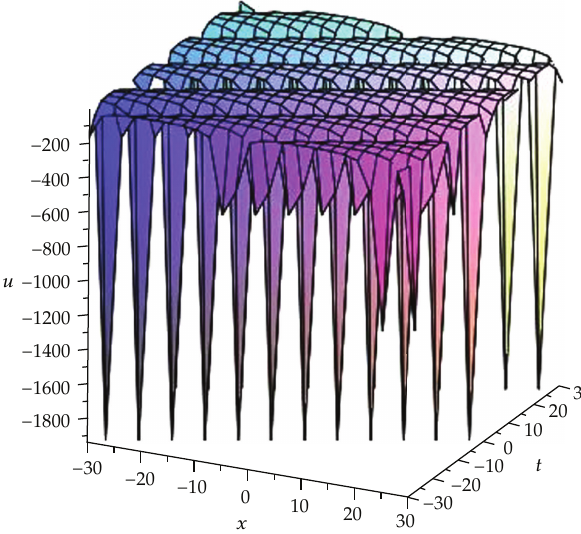
Figure 10: The solution u 13 of GSWW equation with k (cid:7) 0 . 3, c (cid:7) 2, α (cid:7) 3, β (cid:7)